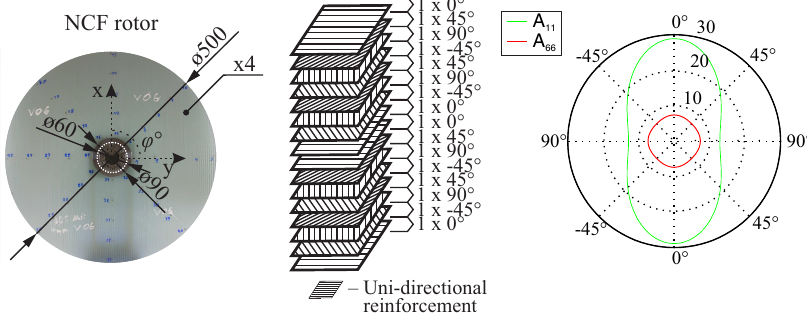
Figure 4. Geometry of a NCF rotor ( left ) with the lay-up ( centre ) and the corresponding homogenised directional stiffness properties A 11 , A 66 , resulting in an in-plane C ARTESIAN -orthotropic behaviour ( right ).